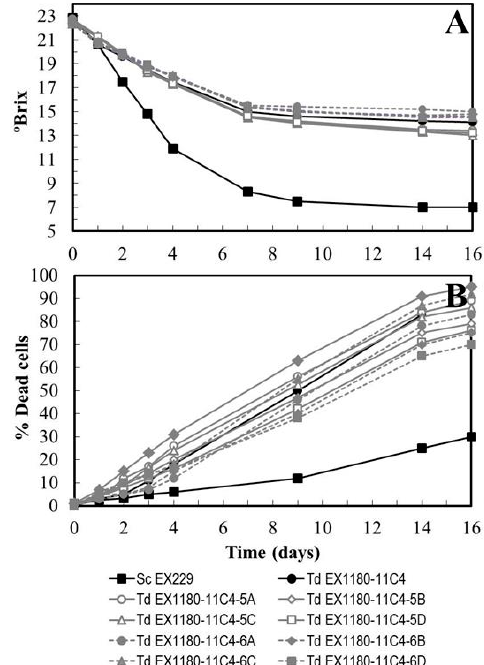
Figure 2. Synthetic must fermentation kinetics of eight large colony size spore clones from two complete tetrads of Td EX1180-11C4 (5A, 5B, 5C, and 5D; and 6A, 6B, 6C, and 6D). ( A ) Degrees Brix ( ◦ Brix) of must / wine. ( B ) Percentage of dead cells. Data are the mean values of three fermentations inoculated with each yeast strain. Standard deviations were less than 8% of the means. The degree of dominance throughout fermentation of each inoculated yeast strain was 100%.